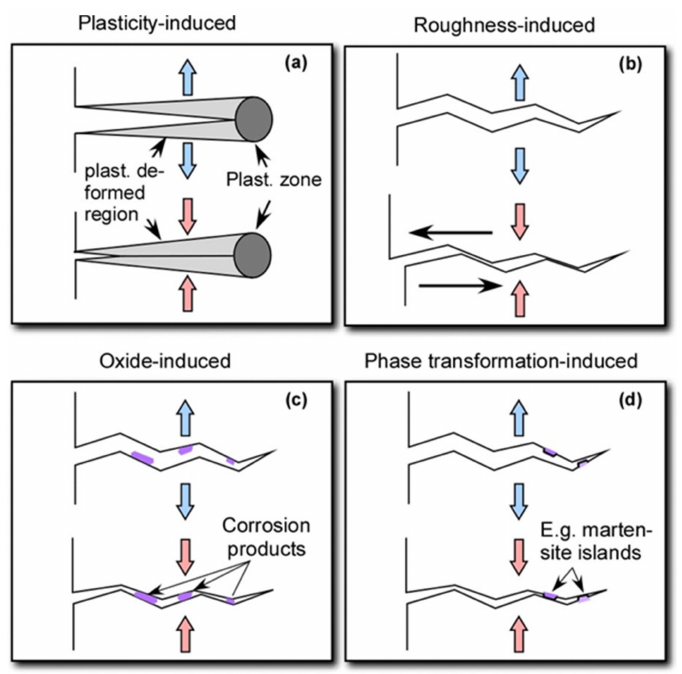
Figure 6. Crack closure mechanisms: ( a ) plasticity-induced; ( b ) roughness-induced; ( c ) oxide-induced; ( d ) phase